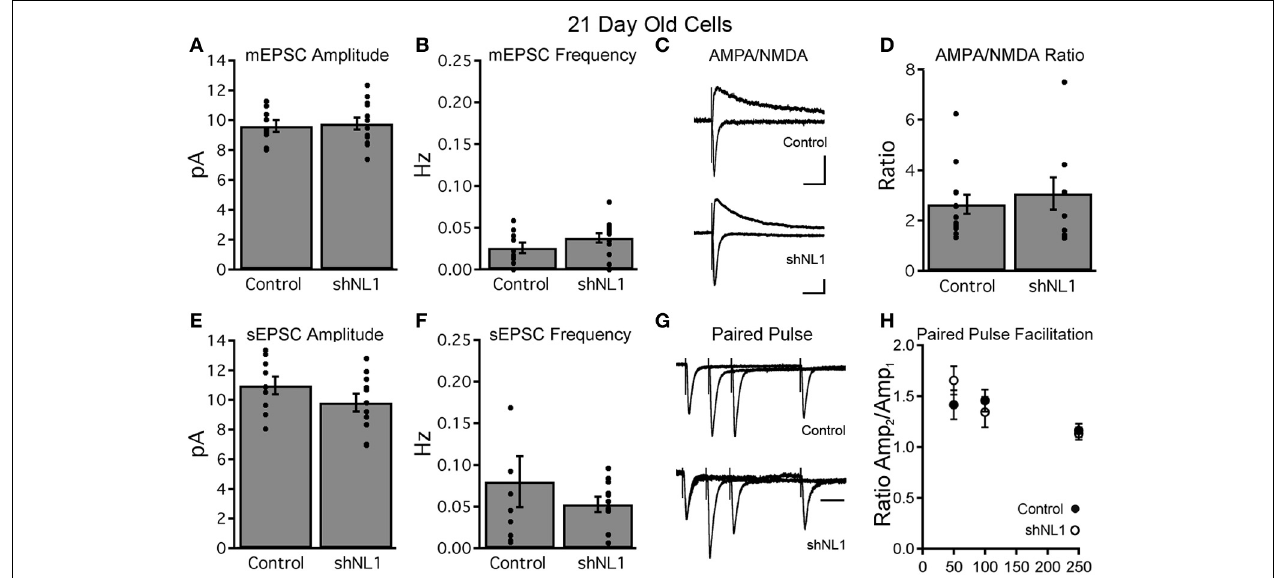
FIGURE 3 | Neuroligin-1 knockdown does not affect basal synaptic transmission in 21-day-old neurons. (A,B) Miniature EPSC recordings from retrovirally labeled control and neuroligin-1 knockdown neurons demonstrate no difference in mEPSC amplitude (A) or frequency (B) between groups (control, n = 10 cells; shNL1, n = 16 cells; p > 0 . 1). (C) Representative evoked EPSCs from labeled granule cells demonstrated similar AMPAR-meditated and combined AMPAR/NMDAR responses at − 70 and + 40mV, respectively, suggesting that 21 day-old shNL1 cells did not selectively lose NMDAR-only synapses. Artifacts truncated for clarity. Scale